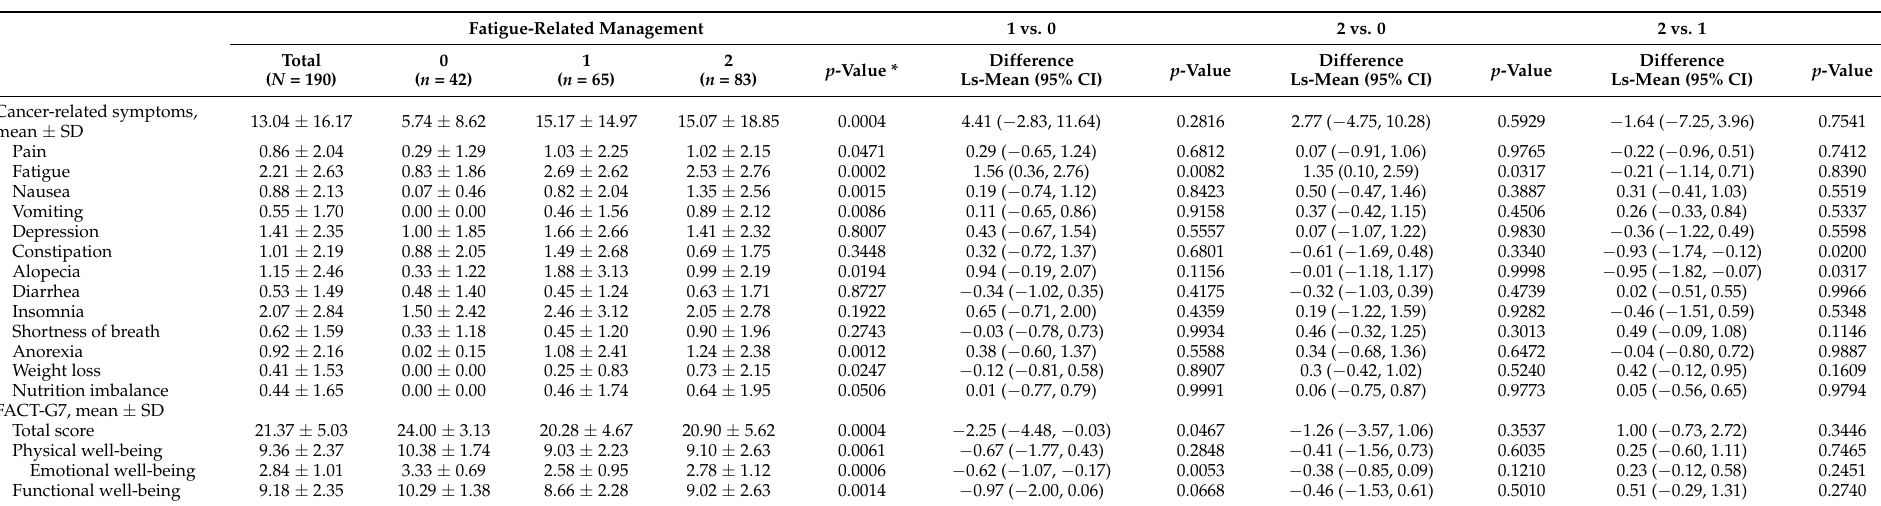
Table 3. Association between cancer-related symptoms, FACT-G7, and the frequency of seeking fatigue-related management. Fatigue-Related Management